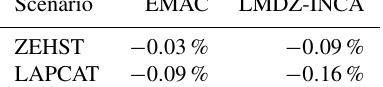
Table A2. Change in global methane lifetime for LMDZ-INCA and EMAC and the ZEHST and LAPCAT scenarios.